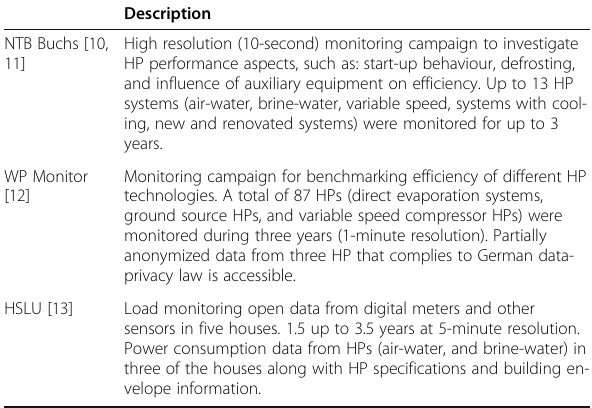
Table 1 (abstract P10). Three data sets